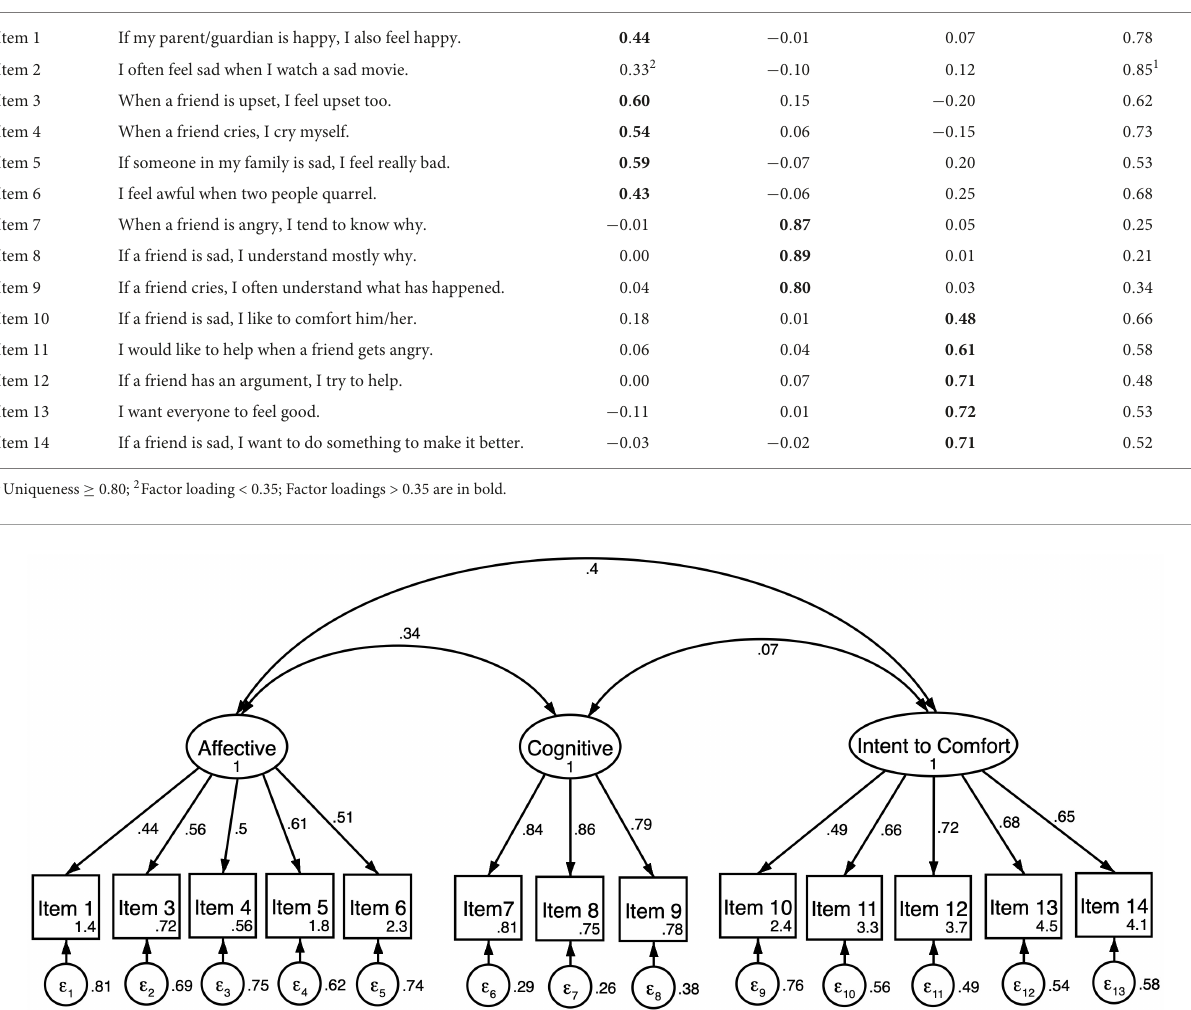
( r = − 0.01; p = 0.796) or cognitive empathy ( r = 0.034; p = 0.412) was statistically significant in correlation